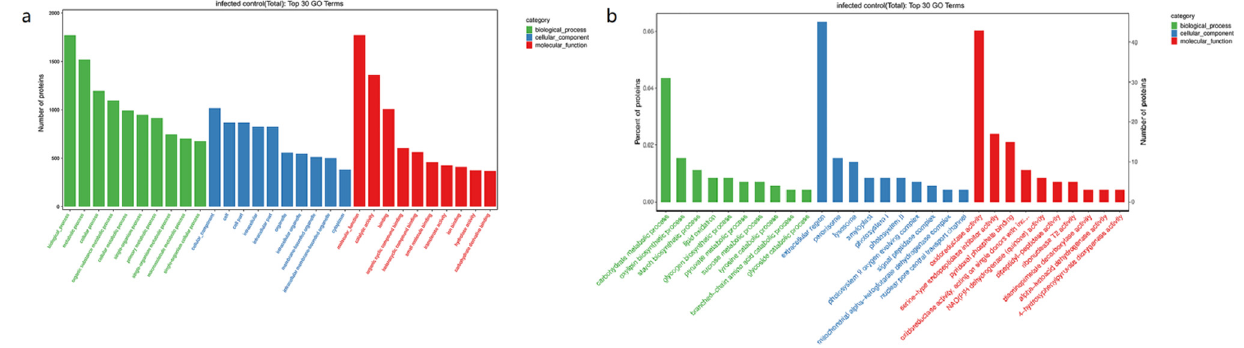
Figure 3. Gene ontology (GO) enrichment analysis of significant DEPs. ( a ) Gene ontology (GO) enrichment analysis of significant DEPs of T. controversa -infected and control libraries. ( b ) Gene ontology (GO) enrichment analysis of significant DEGs of T. foetida -infected and control libraries.